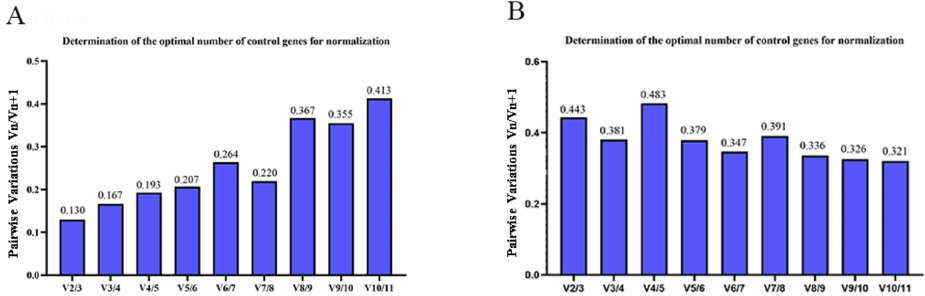
Figure 3. Pairing number variation of RGs. ( A ) Pairwise variations of RGs of Group I; ( B ) pairwise variations of RGs of Group